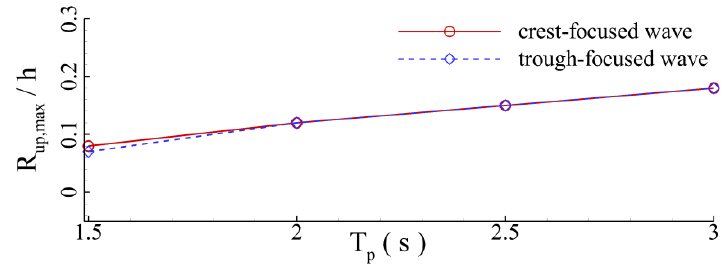
Figure 33. Maximum wave runup height versus the peak wave period.